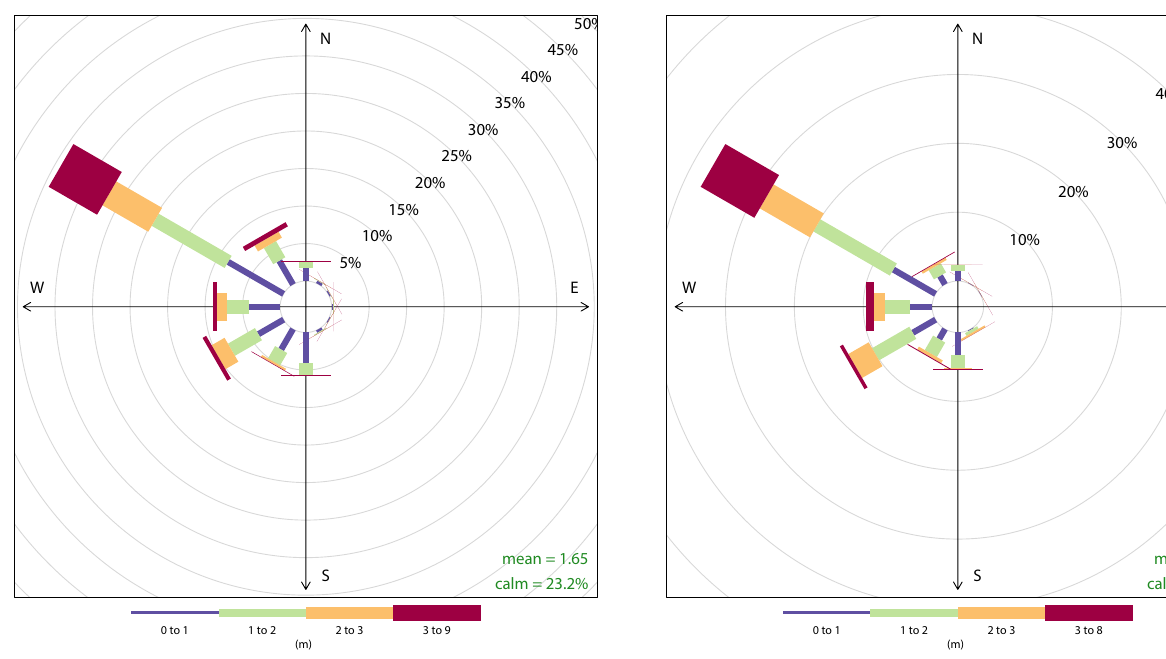
Figure 4. Observed wave climate over 12years of hourly time se- ries at Alghero (1989–2002).